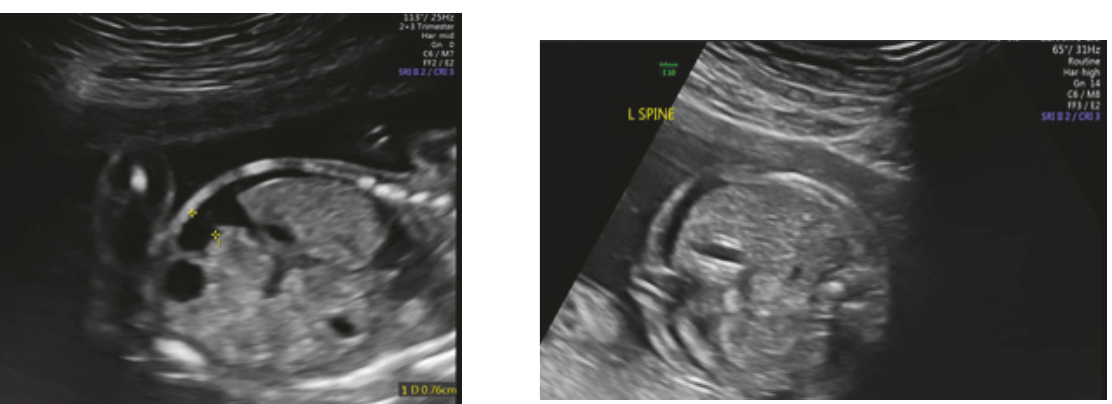
Figure 3: Anatomy ultrasound at 20 weeks’ and 1-day gestation with fetal ascites.